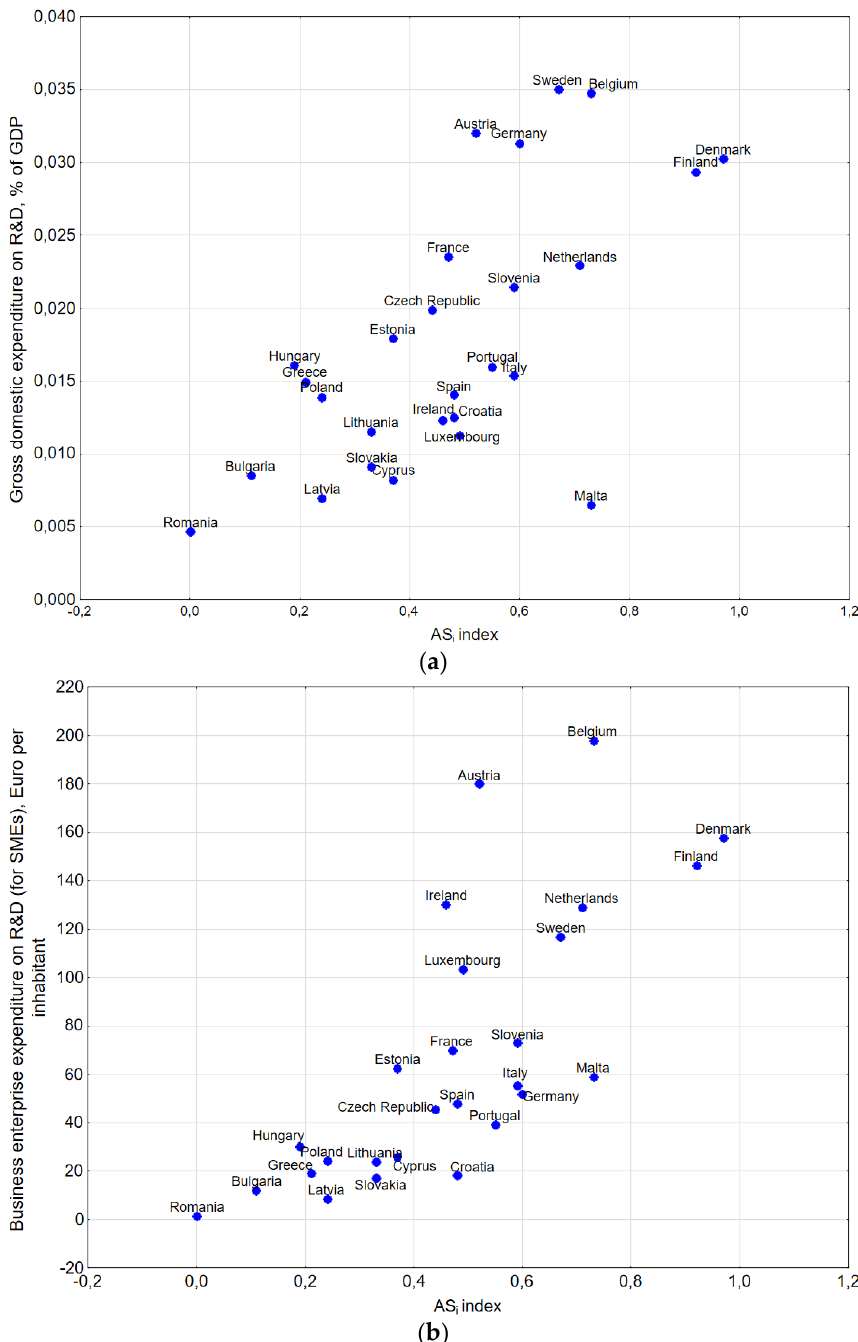
Figure 11. The relationship between selected economic parameters of the EU-27 economies and the value of the digital maturity index of their SMEs (( a )—gross domestic expenditure on R&D, million EUR; ( b )—gross domestic expenditure on R&D, EUR per inhabitant).